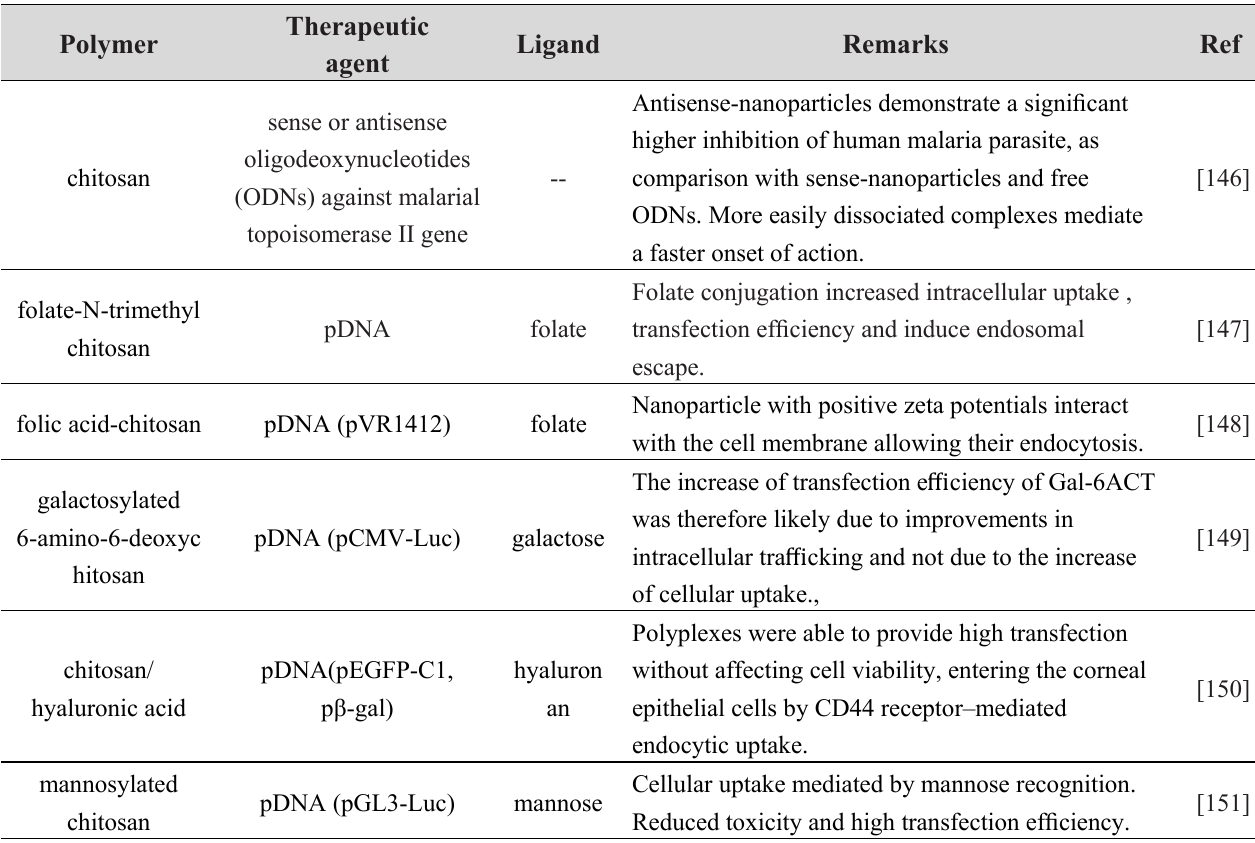
Table 3. Natural - based polymers for gene